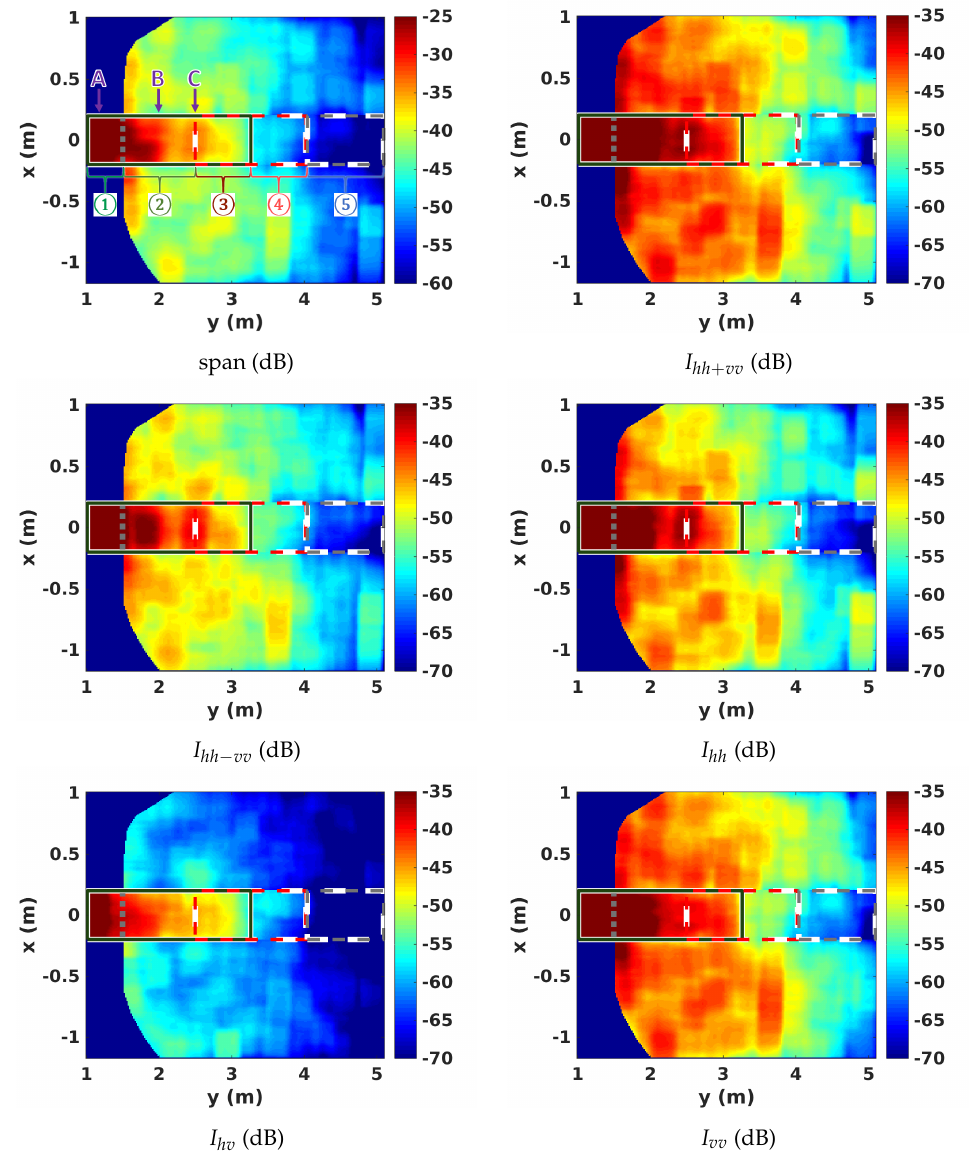
Figure 8. 2D polarimetric intensity images of the VoG